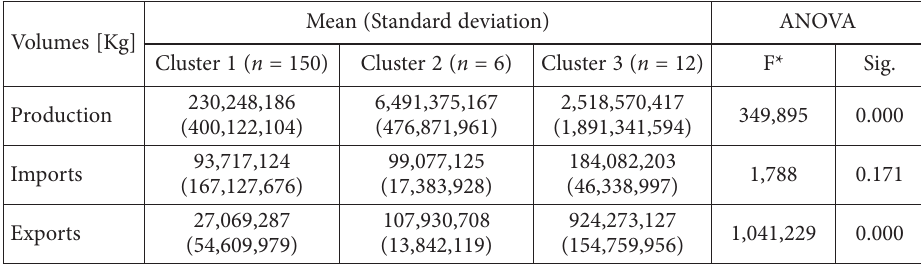
Table 2. Cluster centres and ANOVA for two-stage analysis at the first pre-crisis clustering level (source: own elaboration based on COMTRADE,